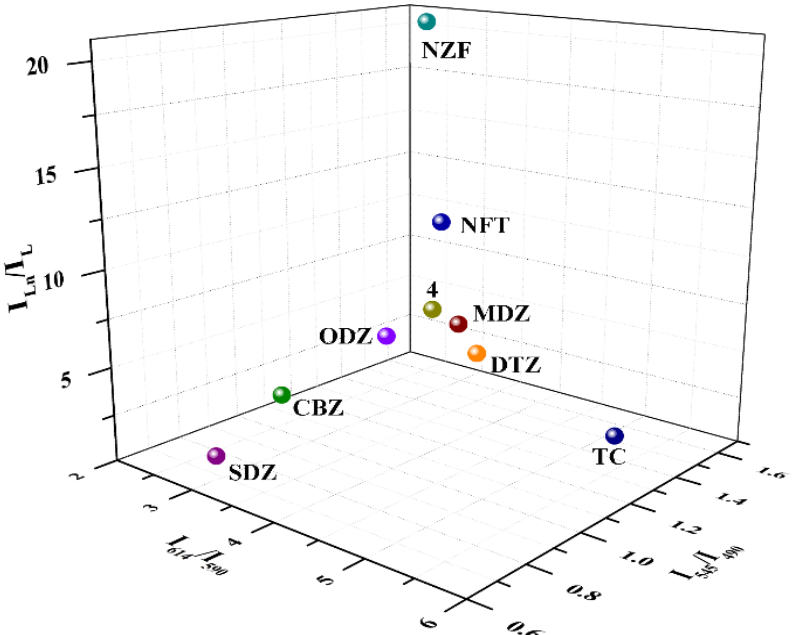
Figure 6. 3D decoding maps of antibiotics based on the emission intensity ratio I 614 /I 590 , I 545 /I 490 , I Ln /I L as x-, y-, and z-axis, respectively.